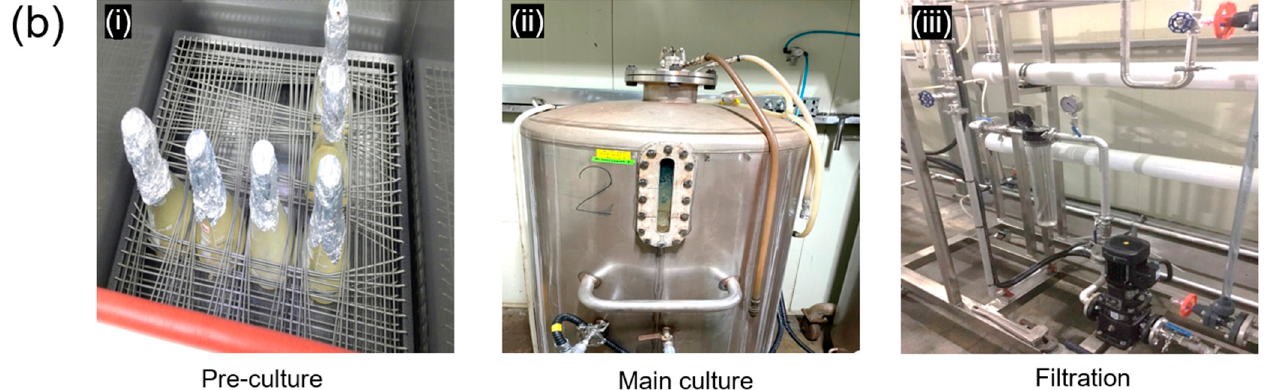
Figure 1. Green manufacturing method of Ceriporia lacerata exo-pharmaceutical substance (CLEPS), including solid culture ( a ) and downstream processes ( b ) such as pre-culture (i), main culture (ii), and filtration (iii).